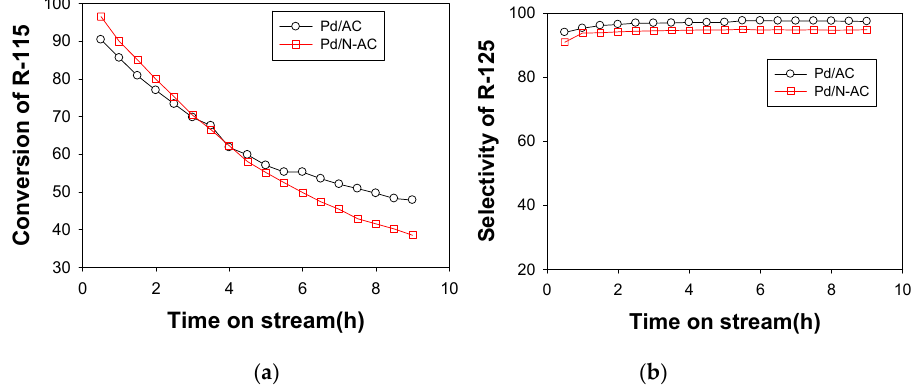
Figure 6. Catalytic performance of hydrodechlorination of R-115 over Pd/AC and Pd/N-AC: ( a ) R-115 conversion and ( b ) R-125 selectivity.